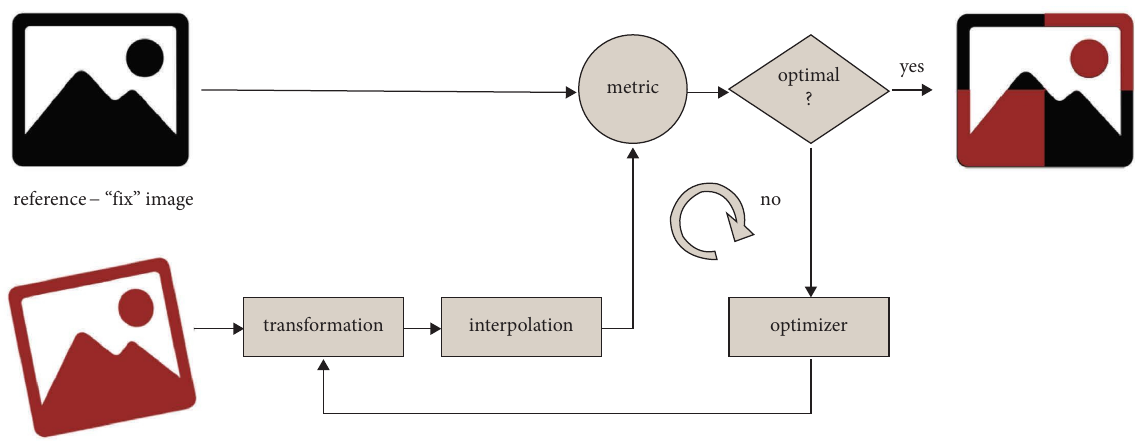
Figure 3: A fow diagram of a basic registration approach. Te reference or fxed image is used as a ground truth, while the foating image is iteratively altered by transformation and alteration until the optimal overlay is achieved. Te registration process is completed when the optimal value for the similarity (based on a specifc metric) between the two images is